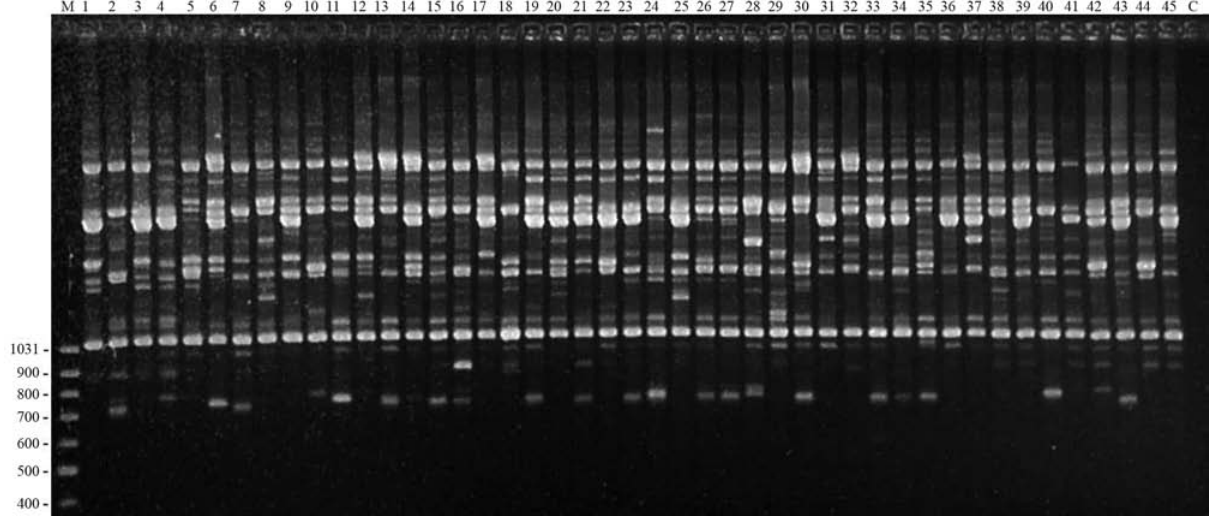
Figure 2 - DNA polymorphism (investigated using primer OPC9) of 45 Eufriesea violacea males from three rainforest fragments. Column M shows the 100 bp molecular weight marker (Biotools); columns 1 to 15 show the results for the São Francisco Park samples (SF); columns 16 to 30 show the results for the Godoy Forest samples (GF); columns 31 to 45 show the results for the Arthur Thomas Park samples (AT), and C =